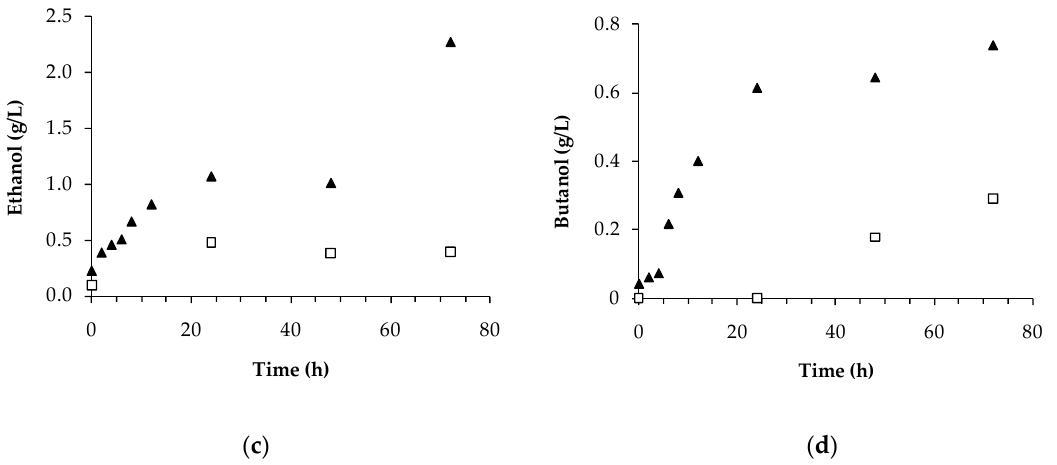
Figure 7. Lactic acid ( a ), acetic acid ( b ), ethanol ( c ), and butanol ( d ) production during syngas fermentation by C. carboxidivorans on Tryptone-Peptone-Yeast extract-Glucose-Arginine medium (TPYGarg) ( ▲ ) and ATCC ® 2713 ( □ ).